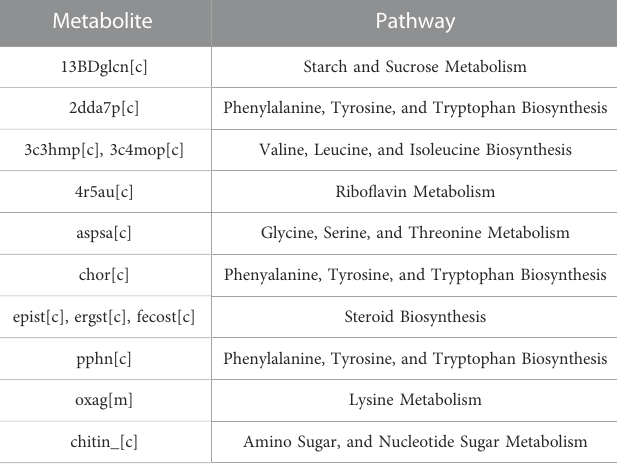
TABLE4Thedistributionofessentialmetabolitesnotfoundinthehumanmodel.